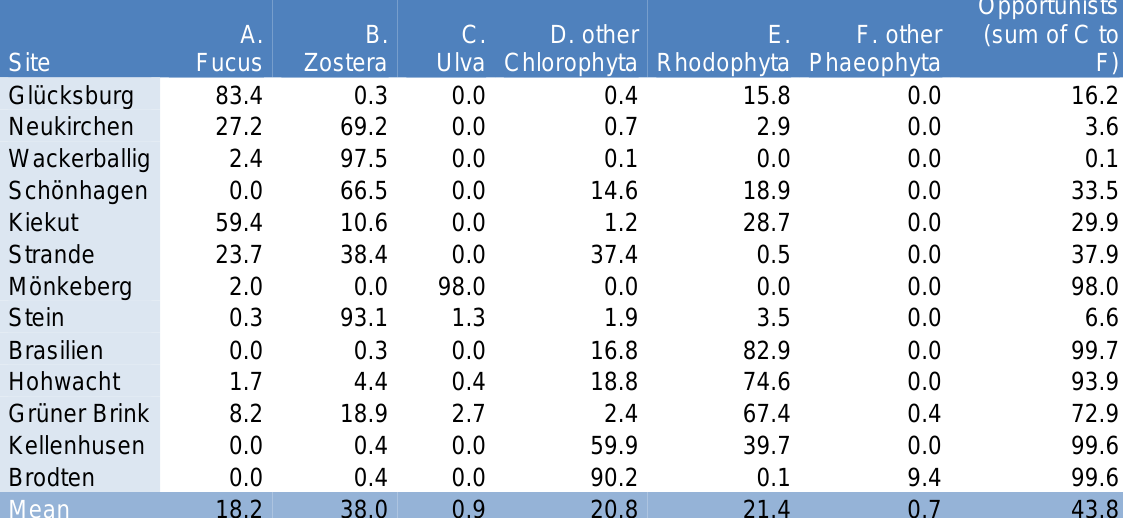
Table S3B: Average contribution [%] of different macrophytes to dry weight of beach wrack sampled in 2012 and